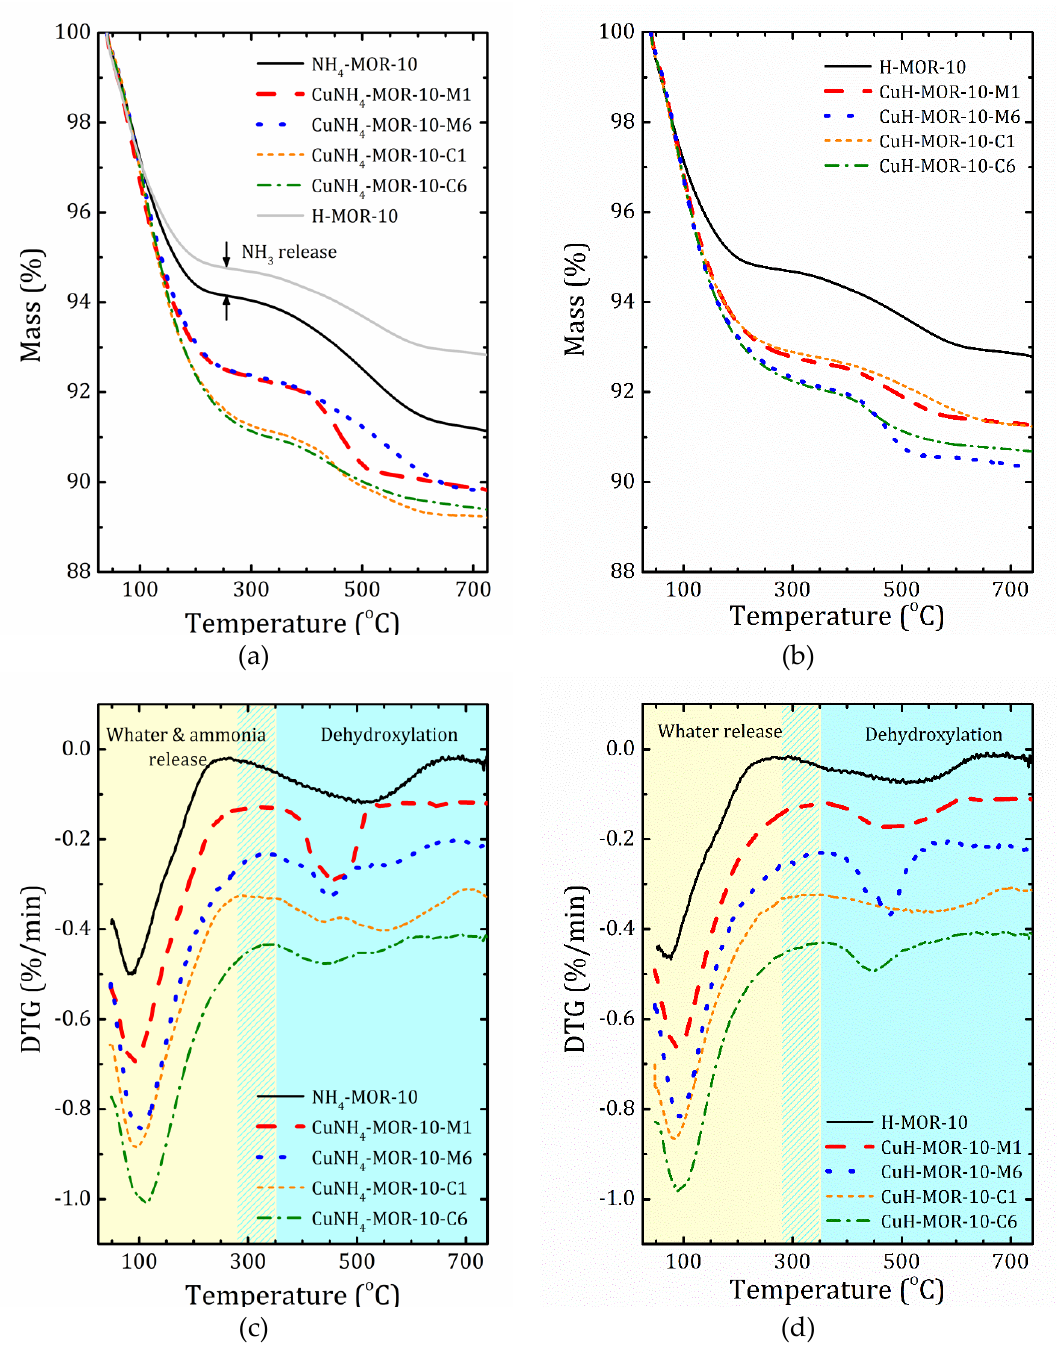
Figure 3. Thermogravimetric (TG) ( a , b ) and derivative thermogravimetric (DTG) ( c , d ) profiles for the starting samples and after the first and six ion-exchange procedures synthetized from the ammonia ( a,c ) and proton ( b,d ) forms. To guide to the eye, the DTG curves for different samples are shifted down with a step 0.1%/min.